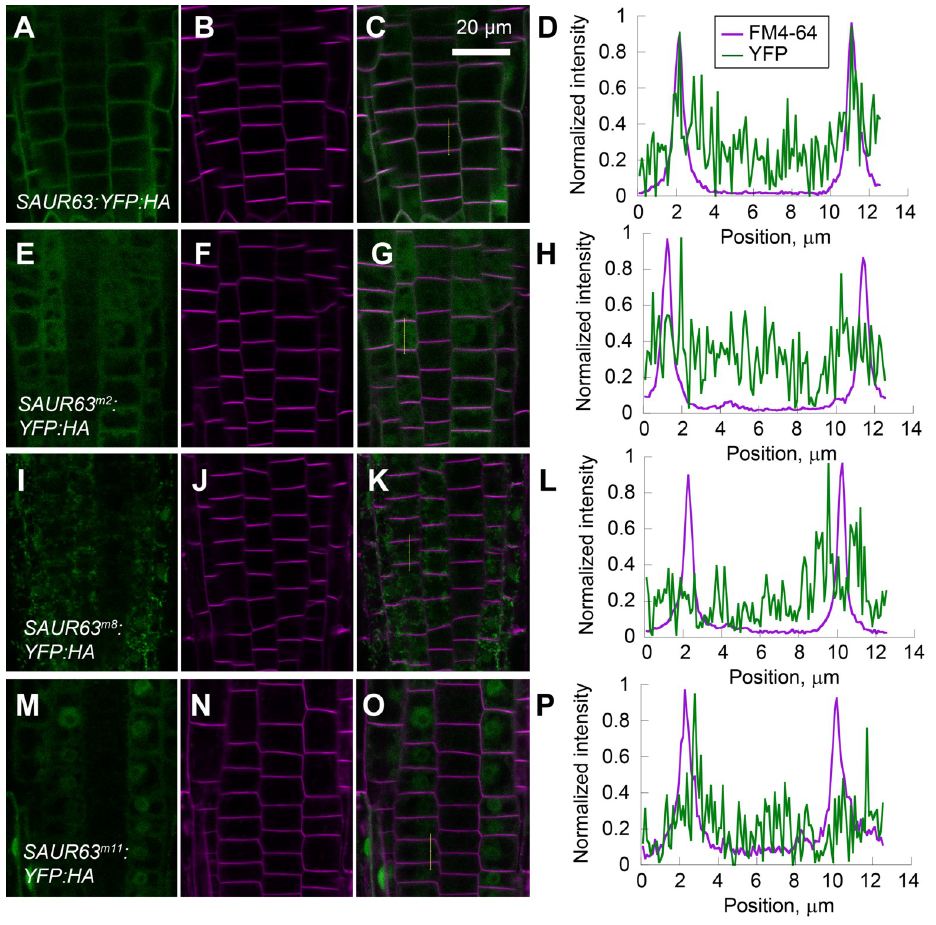
Fig 8. Effects of NAAIRS mutations on SAUR63:YFP:HA localization in root meristem cells. A-D) P 35S : SAUR63 : YFP : HA . E-H) P 35S : S AUR63 m2 : YFP : HA . I-L) P 35S : SAUR63 m8 : YFP : HA . M-P) P 35S :SAUR63 m11 :YFP:HA. Shown are fluorescence confocal microscopy images of YFP (green, A,E,I,M), FM4-64 membrane staining (magenta, B,F,J,N), and both channels together (C,G,K,O) with vertical yellow lines indicating locations of quantitation of fluorescence intensity signals, scaled to the maximum signal along the line (D,H,L,P). Image color channel brightnesses were adjusted for visibility. S12 Fig shows images for additional genotypes analyzed in the same experiment. Scale bar, 20 μ